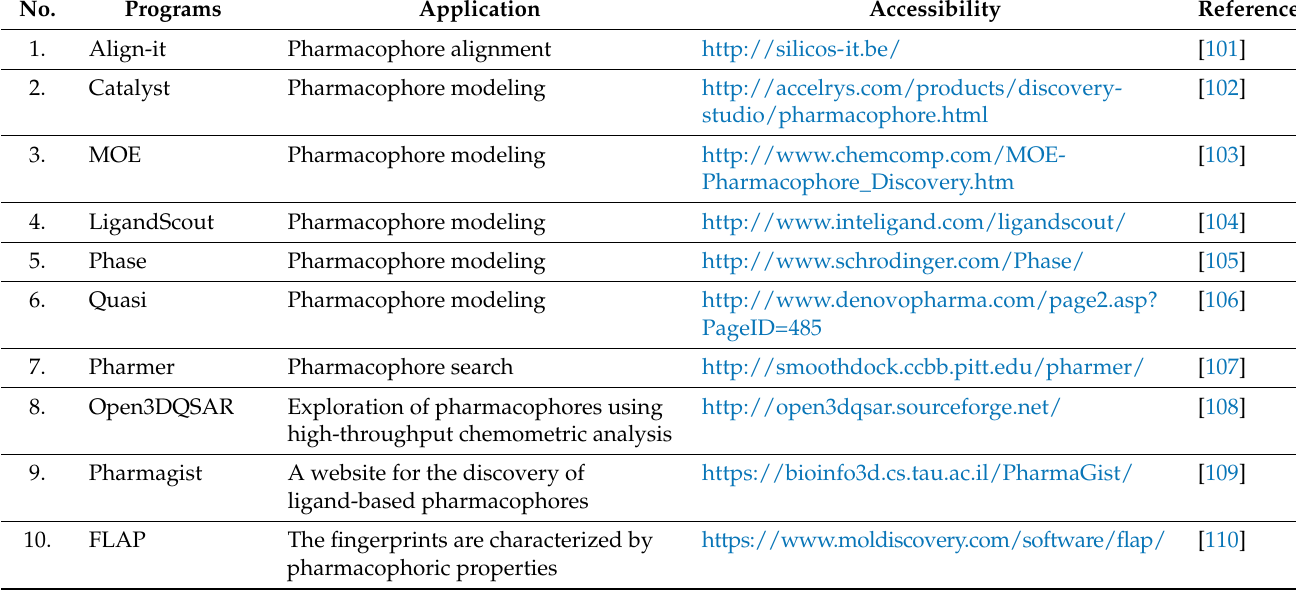
Table 4. Summary of the most usually recognized pharmacophore modeling software used in drug